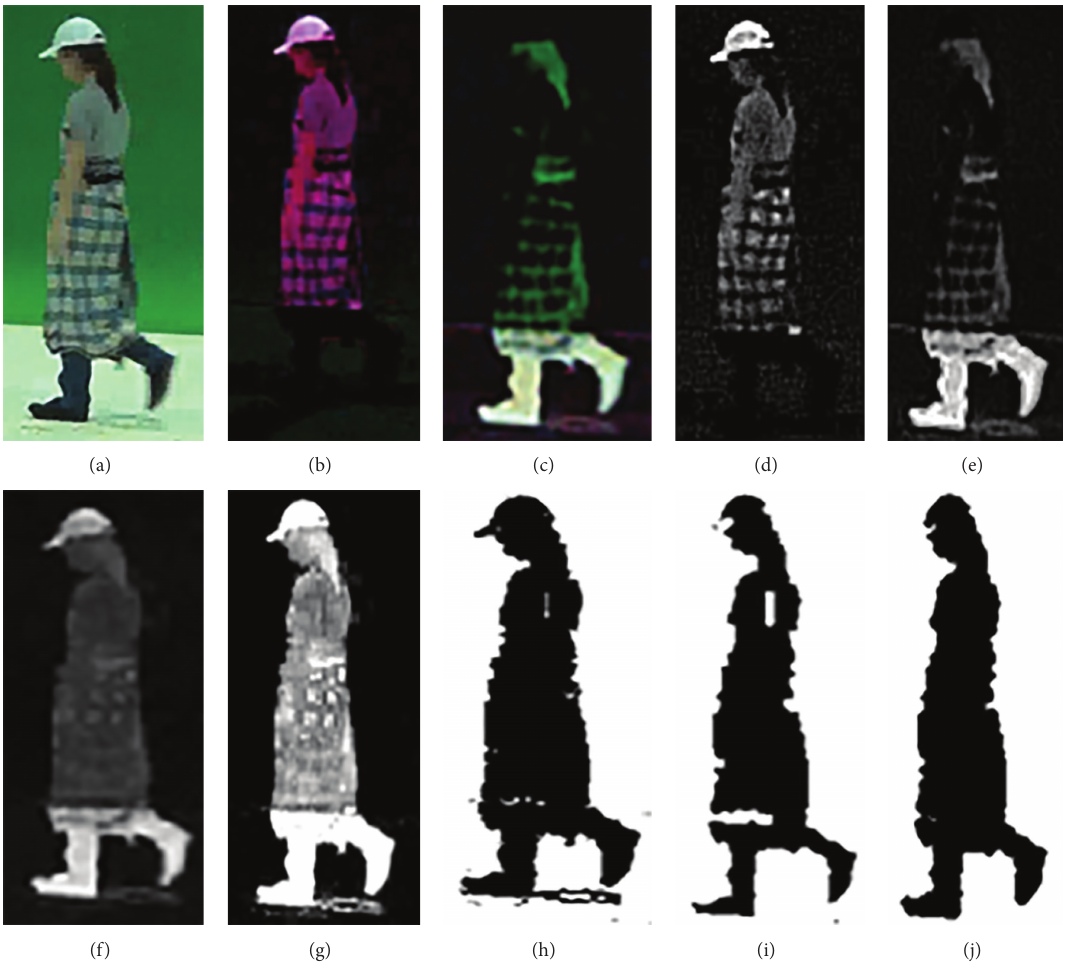
Figure 3: (a) Foreground image. (b) Color image of foreground subtracts background. (c) Color image of background subtracts foreground. (d) Gray level image of (b). (e) Gray level of (c). (f) Addition of (d) and (e). (g) Foreground object after intensity adjustment. (h) Binary image of foreground object. (i) Foreground object after morphological opening. (j) Extracted